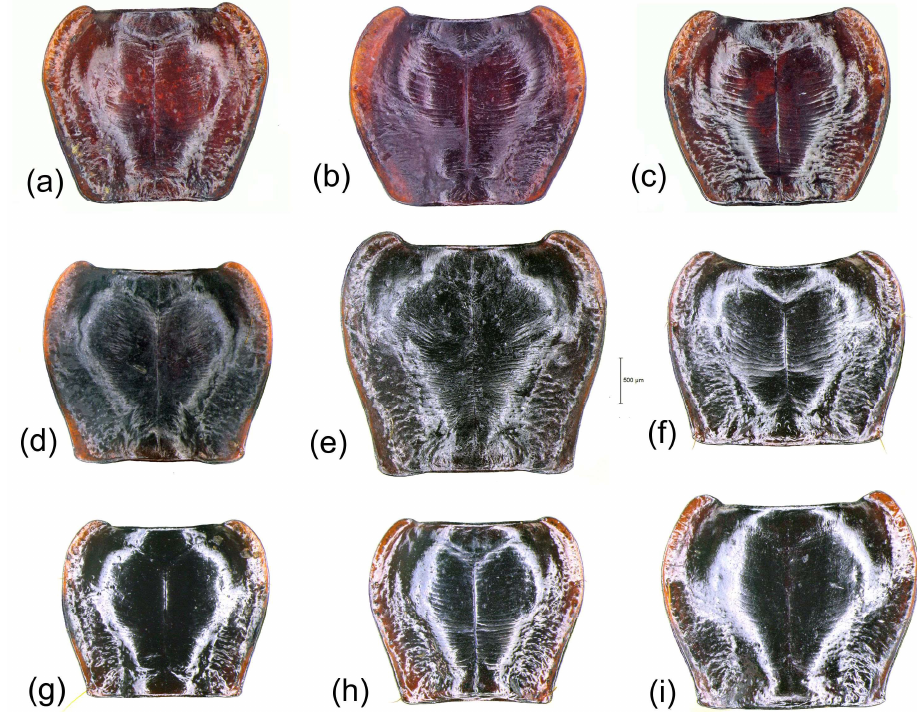
Figure 14. Pronotum of Platynus species: ( a ) P. maritimus n. sp. ; ( b ) P. occitanus n. sp. ; ( c ) P. peirolerii sensu novo; ( d ) P. complanatus; ( e ) P. simonisi n. sp. ; ( f ) P. erythrocephalus; ( g ) P. depressus; ( h ) P. vignai n. sp. ; ( i ) P. teriolensis.